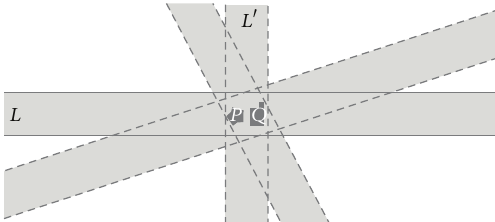
Figure 4: Size and distance matter.